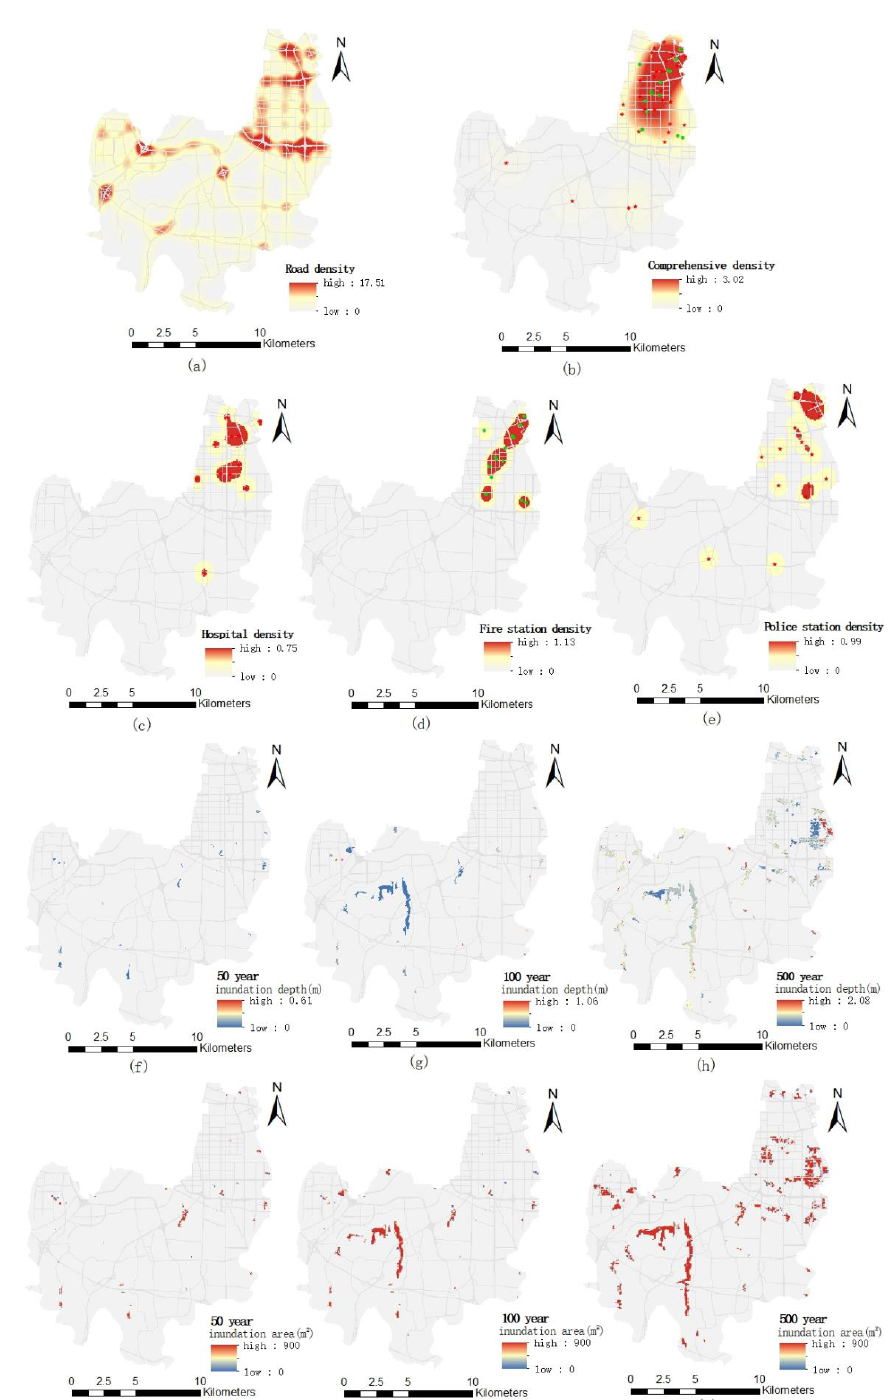
Figure 5. Spatial distribution of emergency response capability evaluation indicators of public